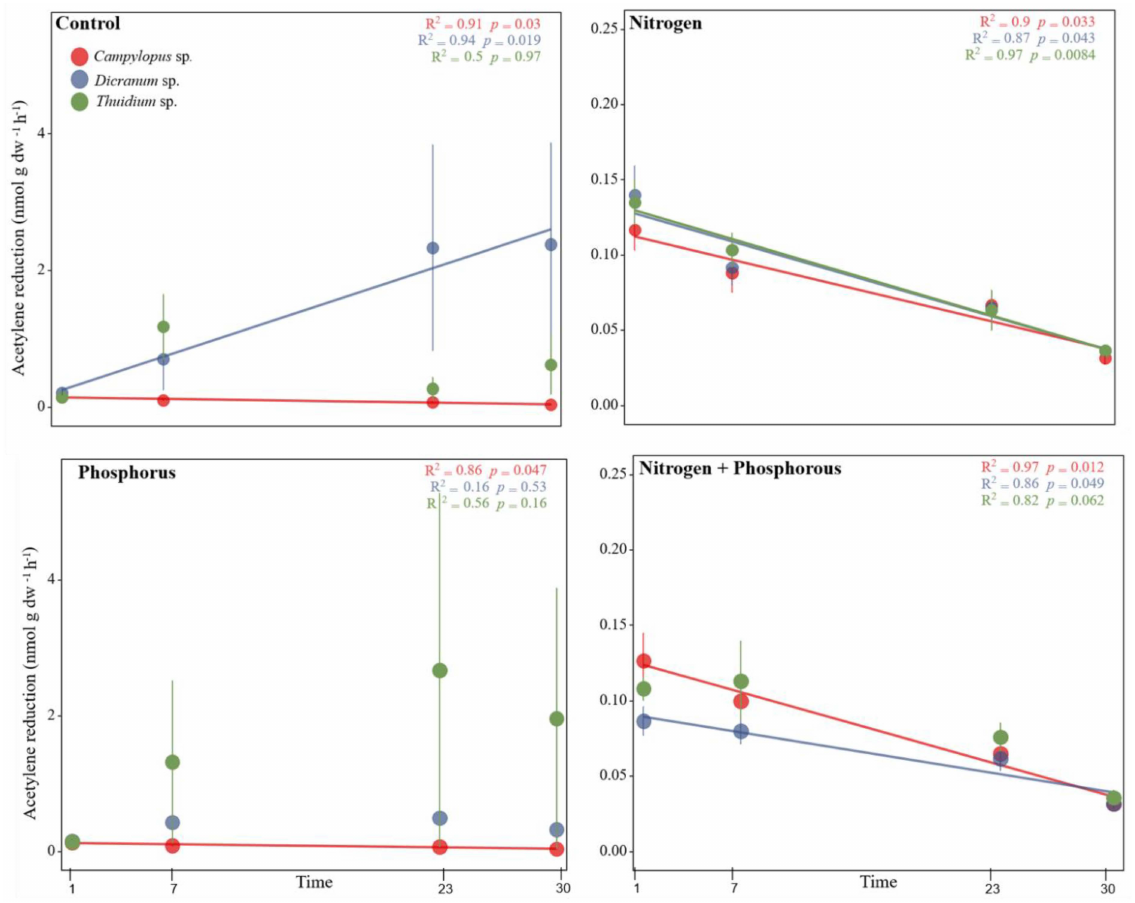
Figure 4. Mean nitrogenase activity (acetylene reduction in nmol g dw -1 h -1 ± SE, n = 6) over time (1, 7, 23 and 30 days after nutrient additions) in response to nutrient additions (control, nitrogen, phosphorus and nitrogen plus phosphorus) in three moss species ( Campylopus sp., Dicranum sp. and Thuidium peruvianum ) collected in a tropical mountain cloud forest in Peru. R 2 and p values are given. Trendlines show significant results ( p < 0.05). Note the different scales at the